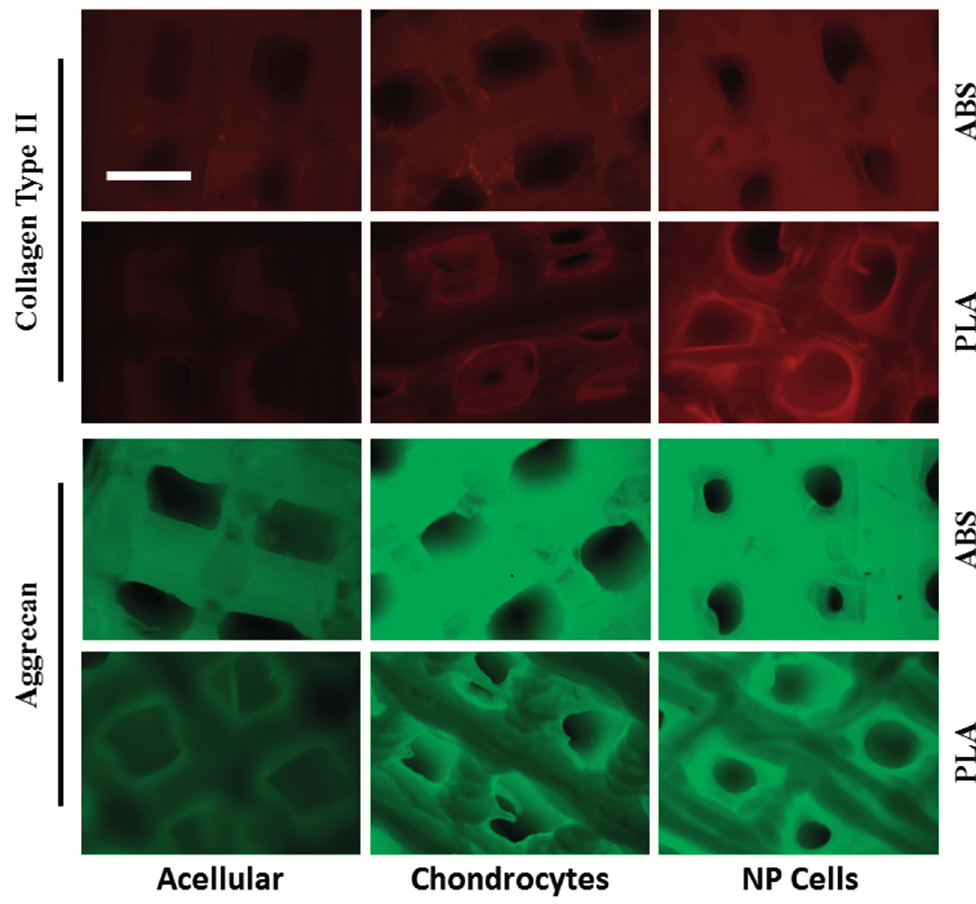
Figure 7. Immunofluorescence analysis of cell-seeded scaffolds. Acellular, chondrocyte-, and NP-seeded ABS and PLA scaffolds were probed by immunofluorescence for collagen type II (red) and aggrecan core protein (green) after 21 days’ culture. Acellular scaffolds show some autofluorescent background. Cell-seeded scaffolds produce fluorescent signals well above background, specifically in regions within the pores, where only cells are growing. Scale bar: 1.0